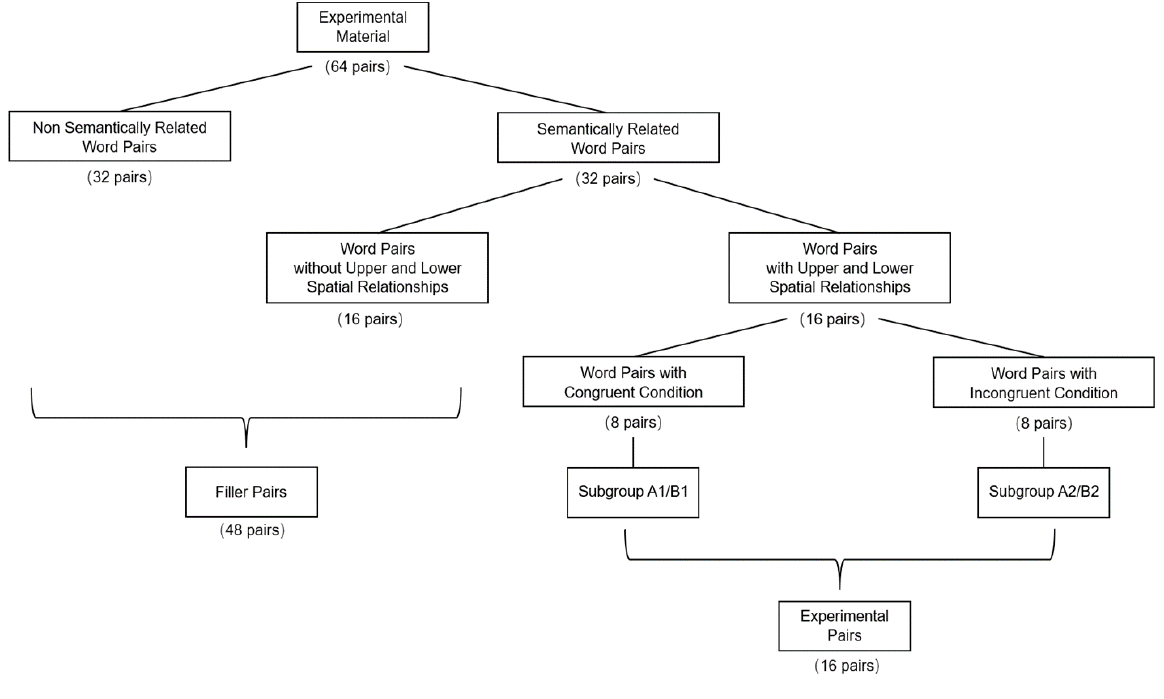
Figure 1. The allocation of materials in Experiment 1.